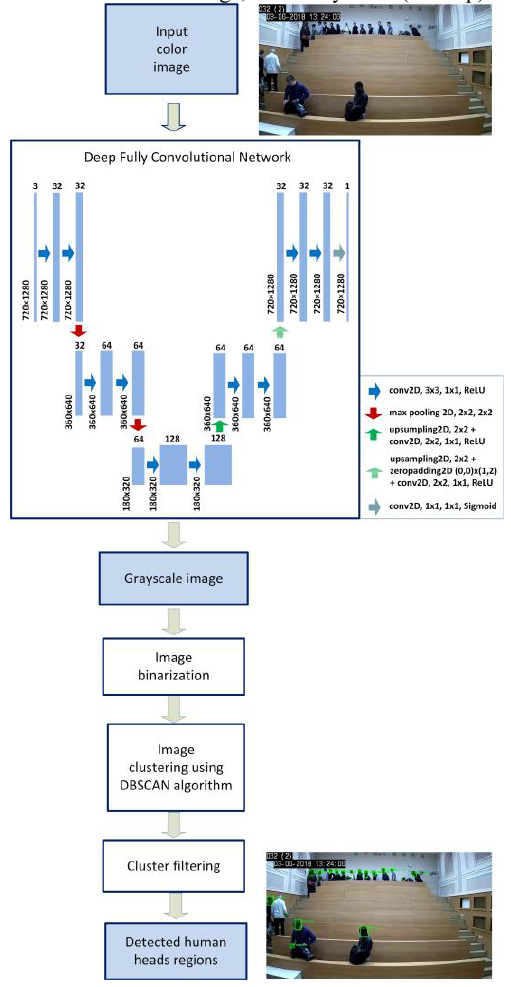
Figure 3. Human head detector based on FCN with